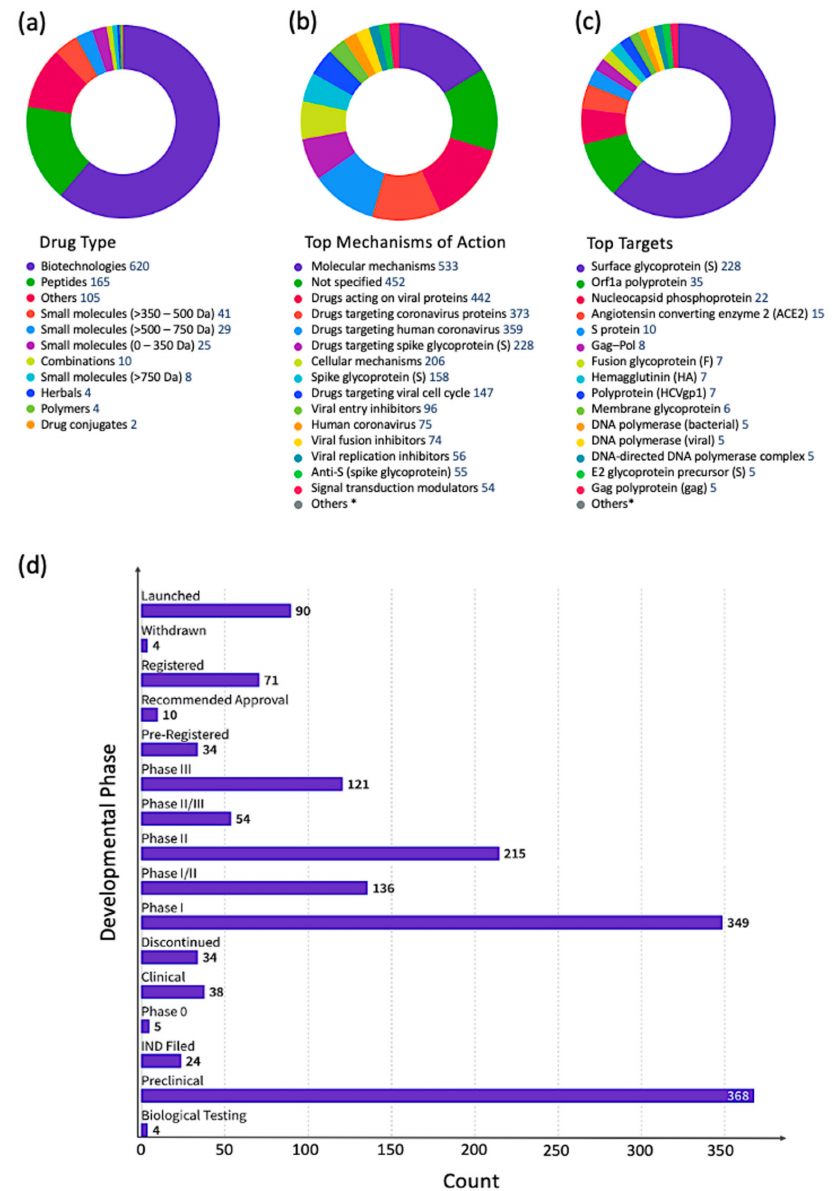
Figure 2. An overview of antiviral drugs under active development for viral infections according to ( a ) drug type, ( b ) top mechanisms of action, ( c ) top targets, and ( d ) developmental status. * Others in ( b , c ) indicate that there are other mechanisms and targets not shown in the figure because they represent a large number of categories with tiny percentages. Data source: Cortellis Drug Discovery Intelligence [37], https://www.cortellis.com/drugdiscovery/, accessed on 24 December 2022, ©2022 Clarivate. All rights